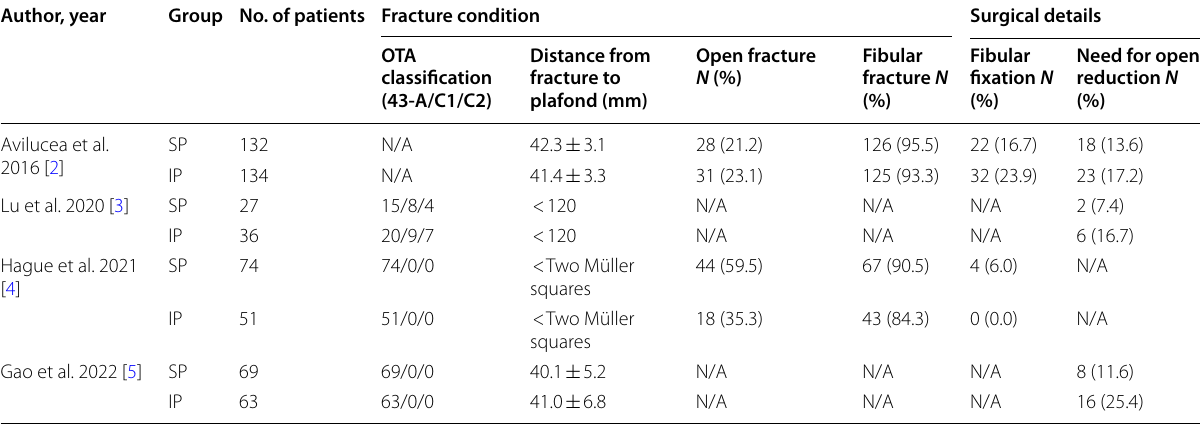
IP infrapatellar, N/A not available, No . number, OTA Orthopaedic Trauma Association, SP suprapatellar